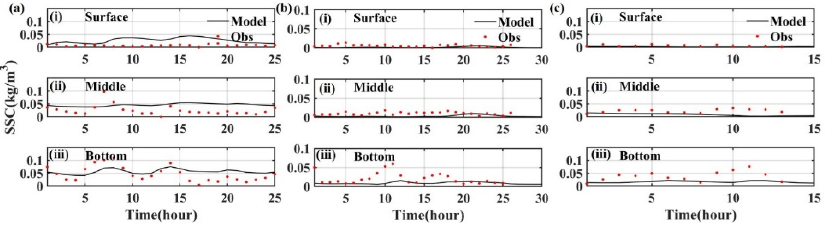
Figure 6. The comparison between computed (red dots) and measured SSC (black solid line): ( a ) represents station A1, the time is in hours from 10:00 on 4 July 2007 to 10:00 on 5 July 2007; ( b ) represents station A2, the time is in hours from 06:00 on 3 July 2007 to 07:00 on 4 July 200; ( c ) represents station A3 the time is in hours from 10:00 on 29 June 2007 to 22:00 on 29 June 2007. ( i ) Surface suspended sediment concentration; ( ii ) middle suspended sediment concentration; ( iii ) bottom suspended sediment concentration.